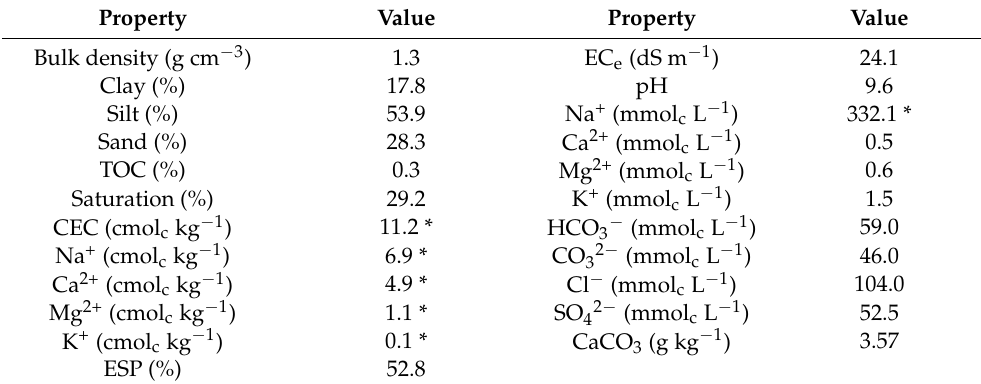
Table 1. Chemical and physical properties of the saline–alkali soil before reclamation. Property Value Property